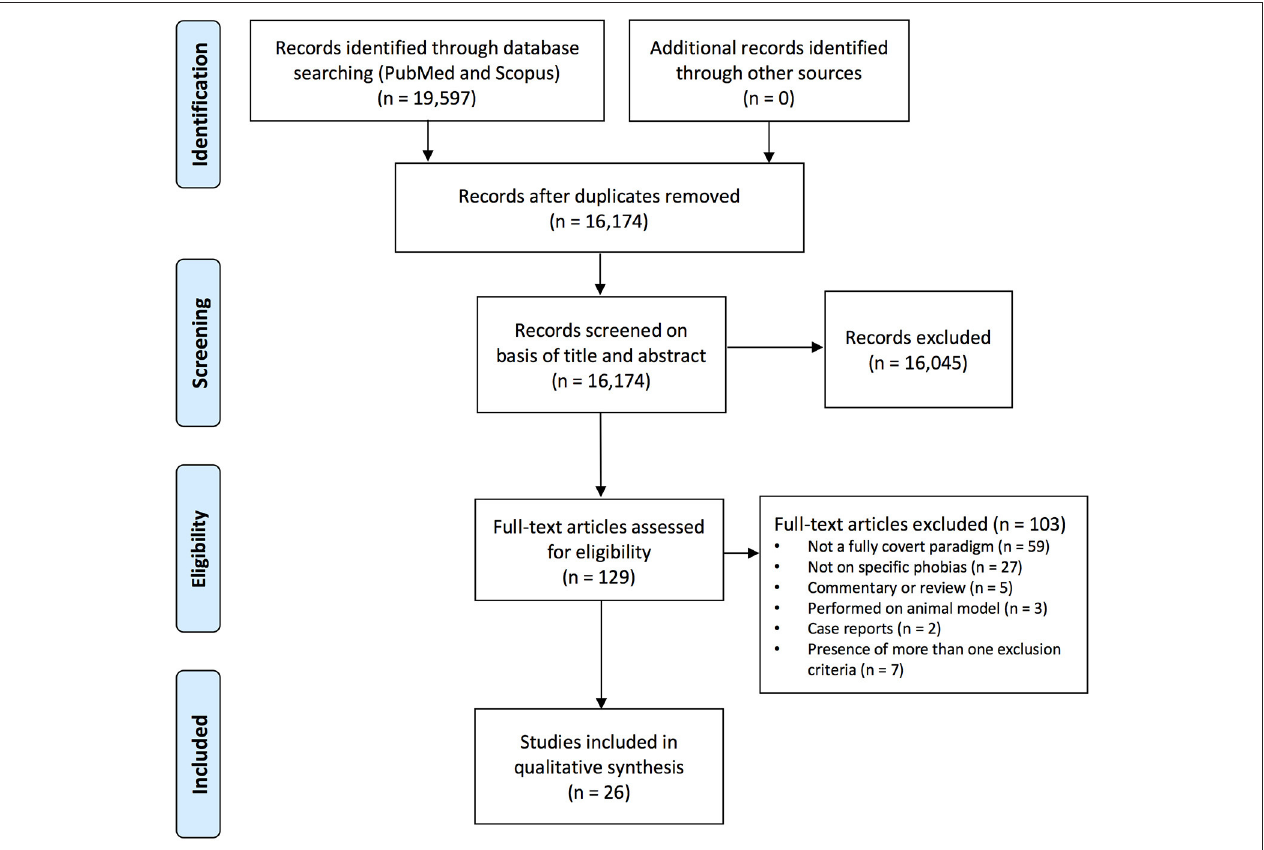
FIGURE 1 | Flow diagram (selection process